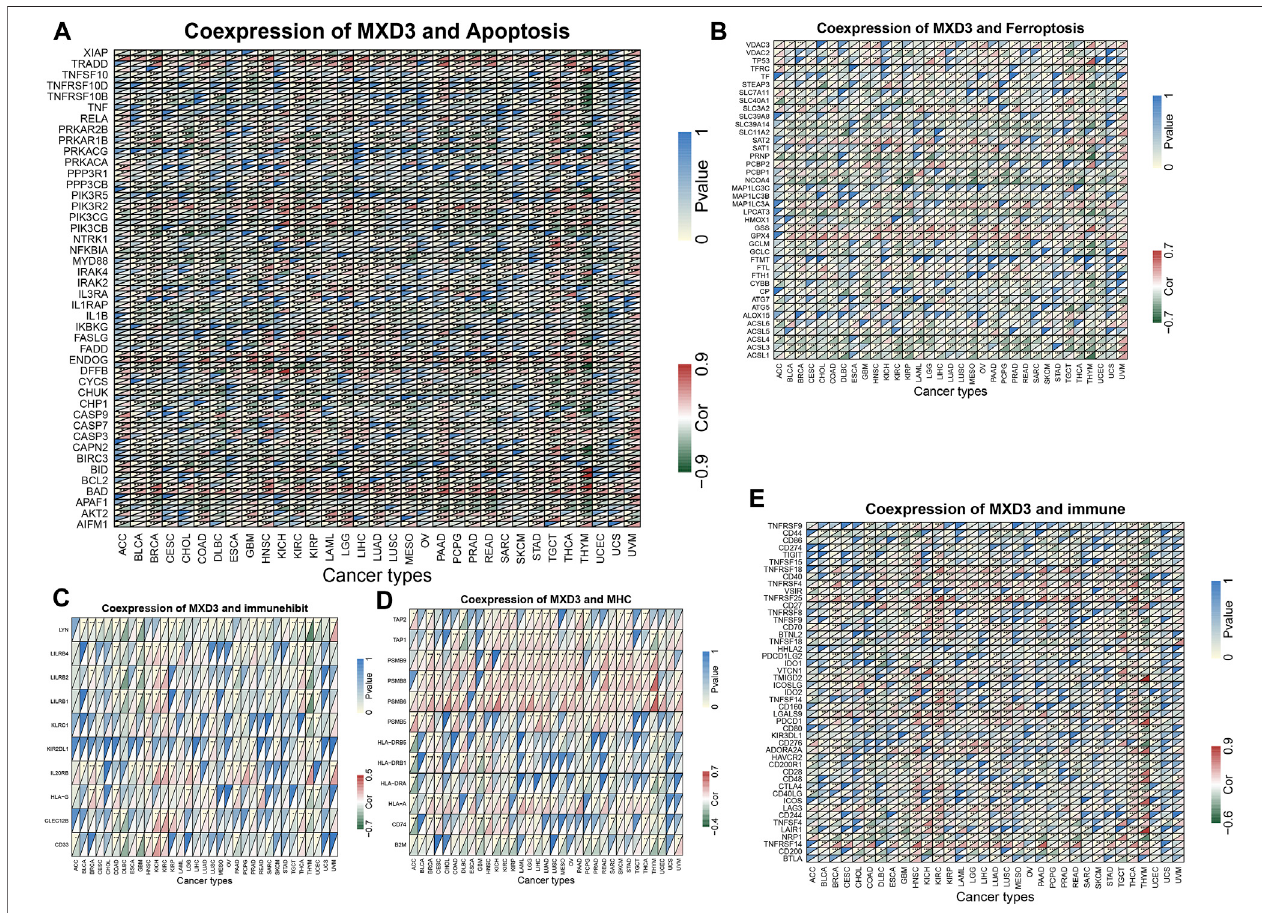
FIGURE 12 | Coexpression of MXD3 with apoptosis (A) , ferroptosis (B) , immunosuppression (C) , MHC (D) , and immune (E) gene